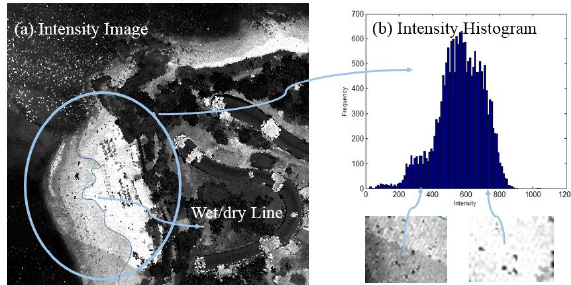
Figure 7: Comparison between intensity image and intensity histogram: (a) Intensity image of part of the sandy beach. (b) Intensity histogram of sandy beach showed in (a).